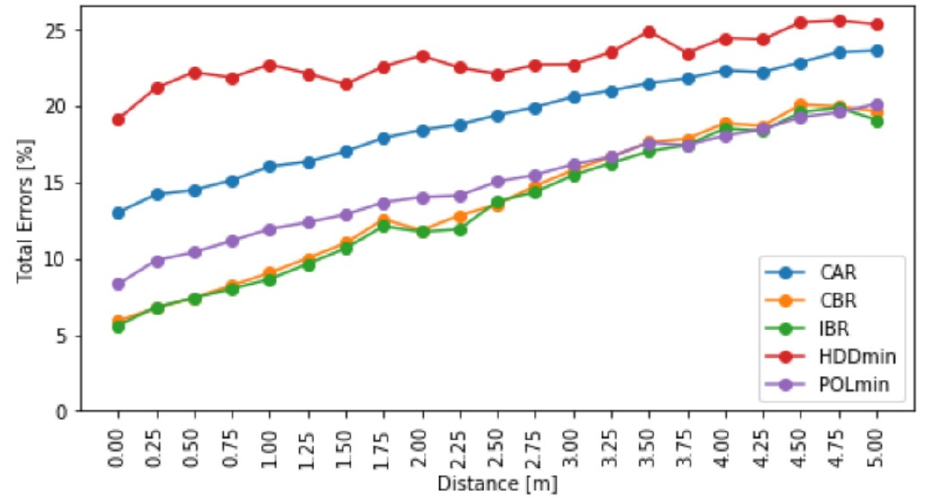
Figure 11. Total errors per distance of generated position deviations for distinguishing modified from replaced buildings.